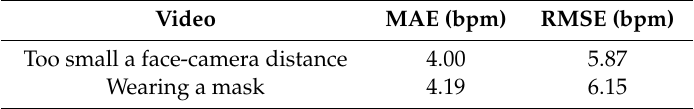
Table 8. Heart rate measurement results from the face–eye location method.